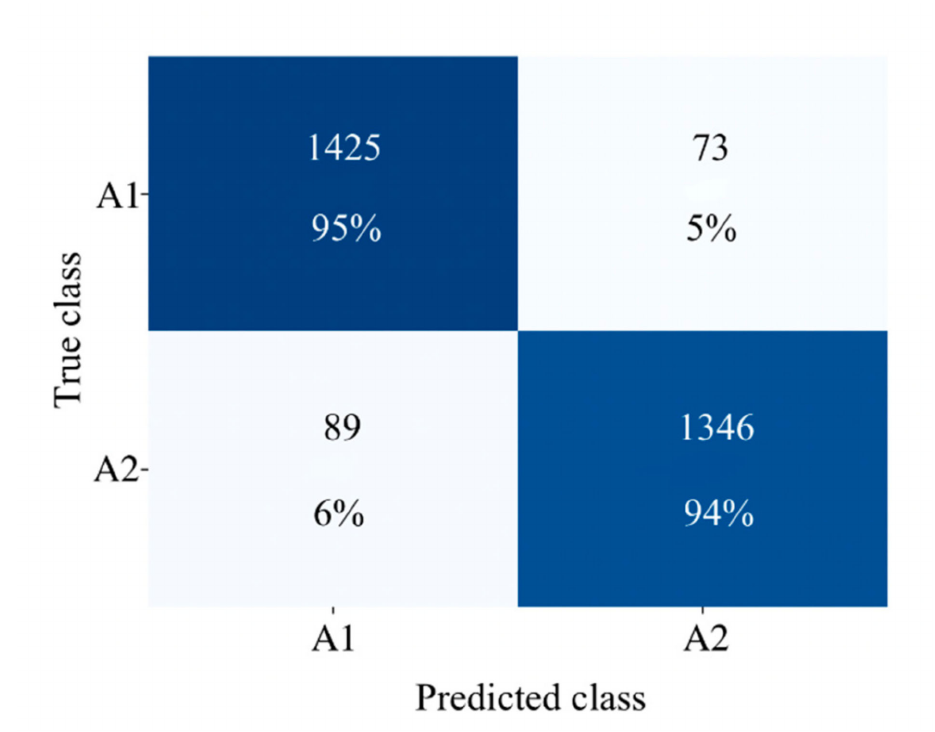
Figure 10. Confusion matrix of classification results for states A1 and